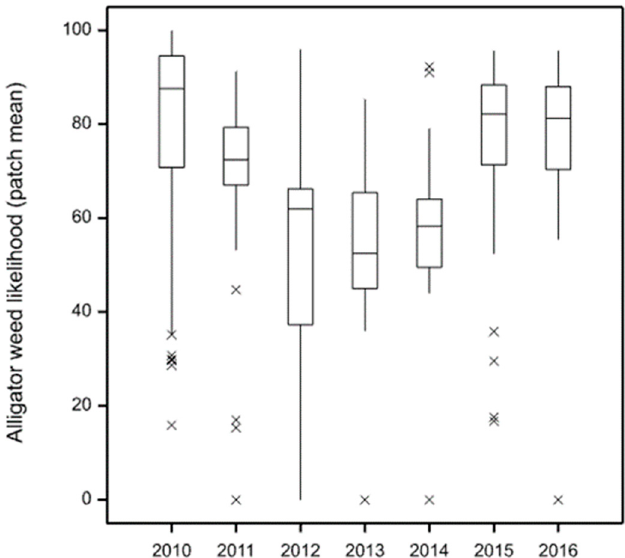
Figure 9. Boxplot of mean alligator weed likelihood values for each manually mapped patch from 2010 to 2016. Boxes represent 25th and 75th quartiles, with median indicated by the central line. Whiskers represent 1.5 times the interquartile range beyond the quartiles (or the maximum value, if smaller). Crosses represent outliers.